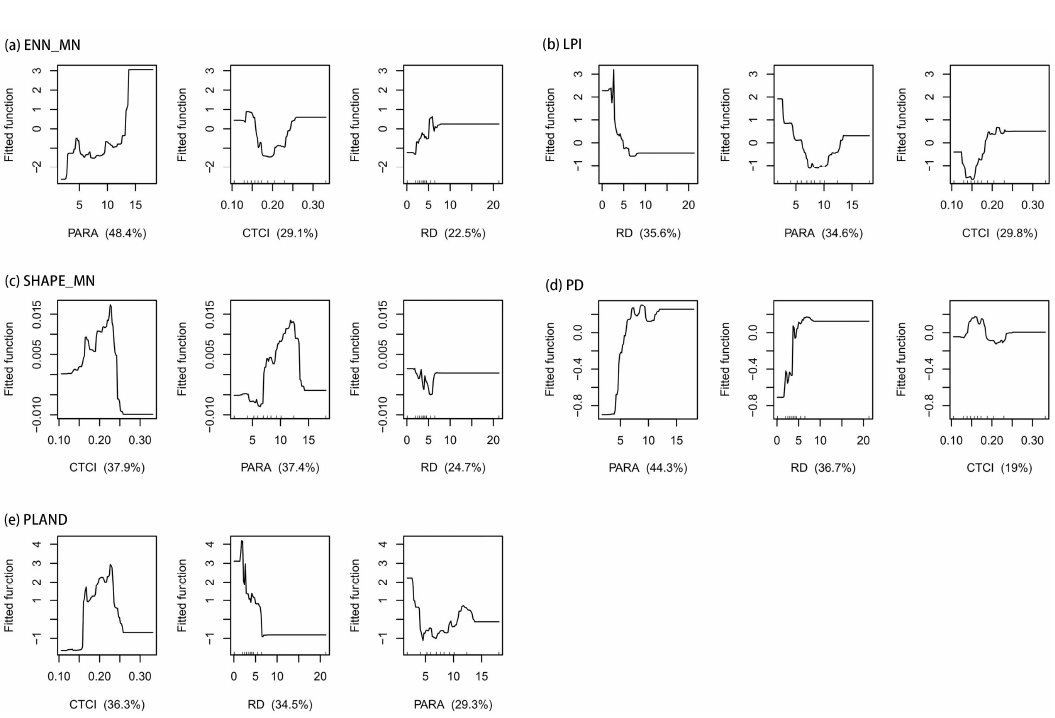
Figure 5. Partial dependence plots for boosted regression tree analysis showing the effects of urban form predictors on: ( a ) ENN_MN (mean Euclidian nearest neighbor distance), ( b ) LPI (largest patch index), ( c ) SHAPE_MN (mean patch shape index), ( d ) PD (patch density), and ( e ) PLAND (percentage of landscape). Numbers enclosed inside parenthesis indicated the relative importance of